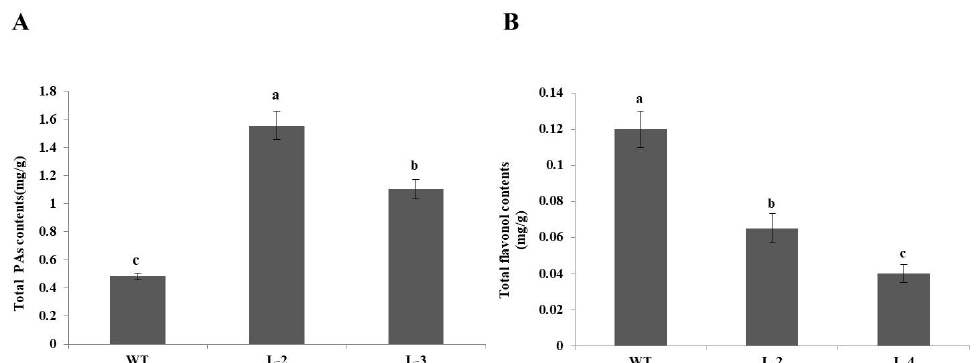
Figure 7. Quantification of proanthocyanin and flavonol in transgenic and wild type tobacco flowers. ( A ) PA contents and ( B ) flavonol contents. Small letters showed a significant difference at the level of p < 0.05 by using LSD statistical analysis.